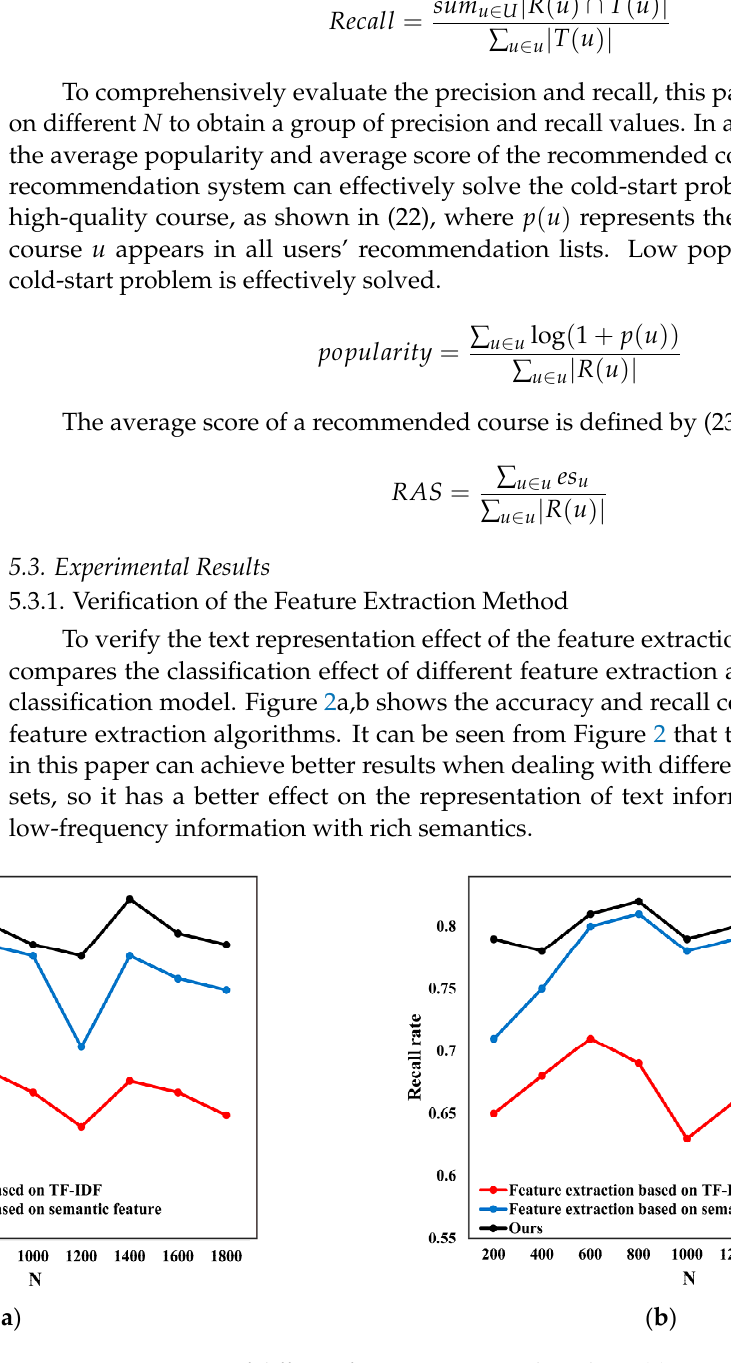
( c ) Figure 3. CP , DBI and Cluster Radius comparison results: ( a ) CP comparison; ( b ) DBI comparison; ( c ) Cluster Radius comparison. To prove that the improvements of the K-means algorithm are statistically significant, this paper adopted the “Mann-Whitney U test” [21], one of the non-parametric statistical tests, to provide statistical evidence. As the goal of the proposed student grouping method is to find a suitable K with a relatively small CI , this paper conducted a series of experiments to record the smallest CI values of the improved K-means algorithm and the original K-means algorithm, based on data from same students. A total of 15 sets of CI values for different students are finally obtained, as shown in Table 3. The H 0 hypothesis is “ CI values of the original K-means algorithm ≤ CI values of the improved K- means algorithm”. The final p value is 0.004203, which is smaller than the significance level α (0.05). Therefore, H 0 is rejected, which means that the randomly selected CI value of the original K-means is considered to be greater than the randomly selected CI value of the improved K-means. Hence, the improvements in the improved K-means are statistically significant.